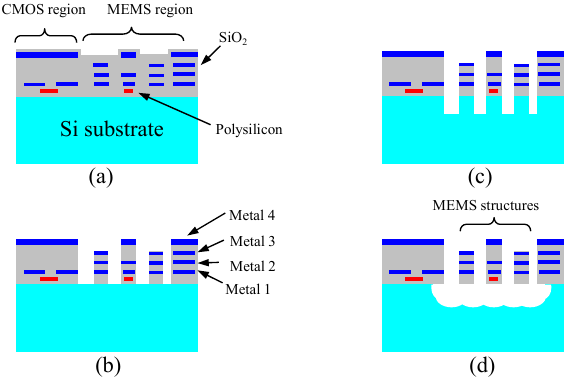
Figure 6. Dry-etching-based post-CMOS fabrication process for MEMS structures made of CMOS thin films [57]. ( a ) CMOS wafer or die; ( b ) SiO 2 etching; ( c ) Silicon deep reactive ion etching (DRIE); ( d ) Silicon reactive ion etching (RIE) with lateral undercut.